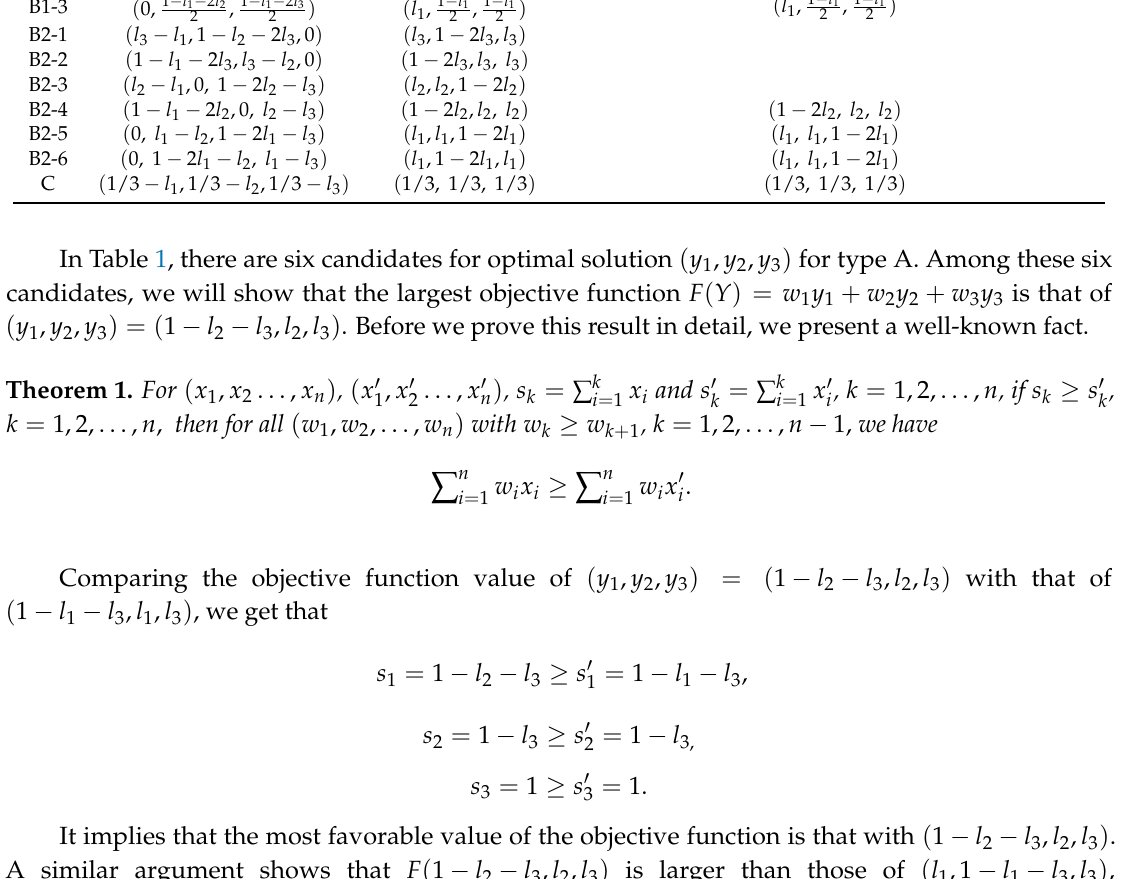
) for 3COWAL with l